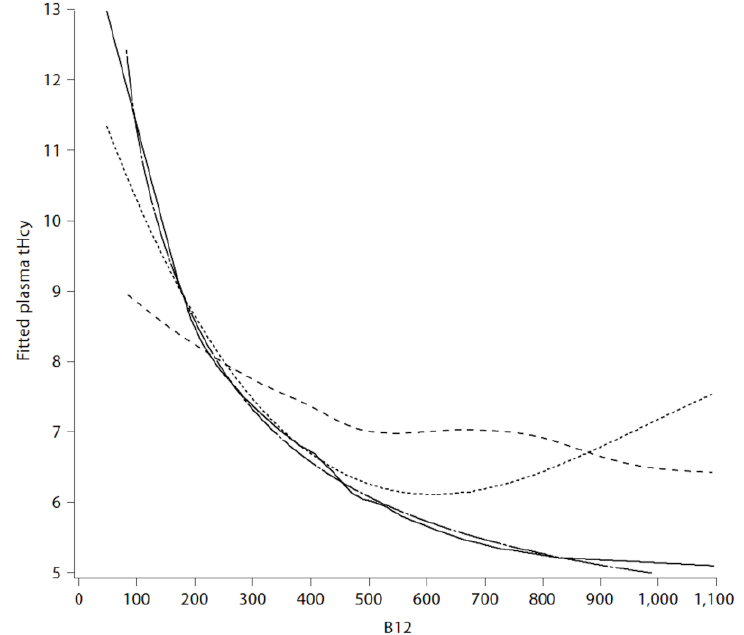
Figure 3. Polynomial and inverse regression, spline, loess fits for plasma tHcy with B 12. Solid, dotted, long dashed and short dashed lines represent loess, cubic polynomials, cubic polynomials of the inverse covariate and smooth splines, respectively. (Reproduced by permission of Karger from [44]).